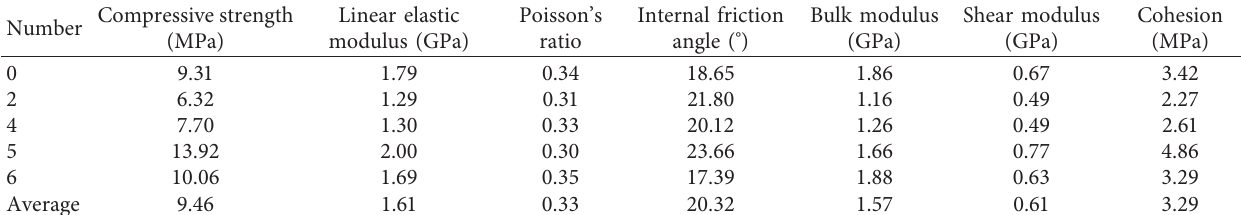
Figure 9: Relationship between Poisson’s ratio and the friction angle. Table 3: Mechanical parameters obtained from the